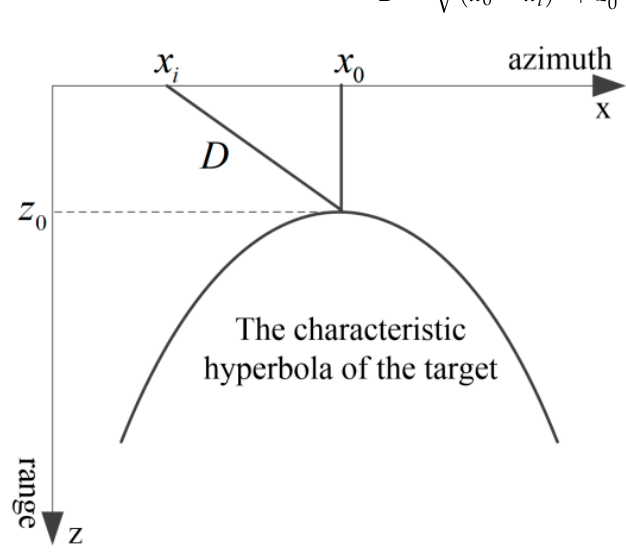
Figure 3. Geometric relationship of the buried target.